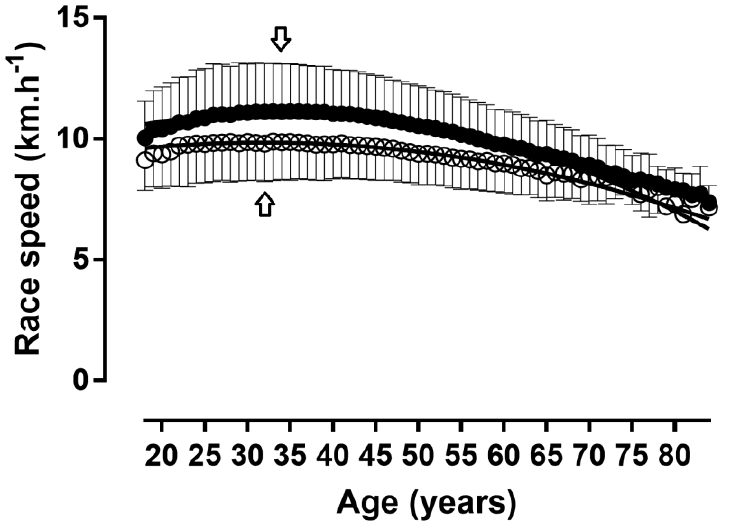
Figure 8. Running speed in 1-year age groups. Arrows denote age of peak performance. Error bars represent standard deviations; = women, ⚫ = men.